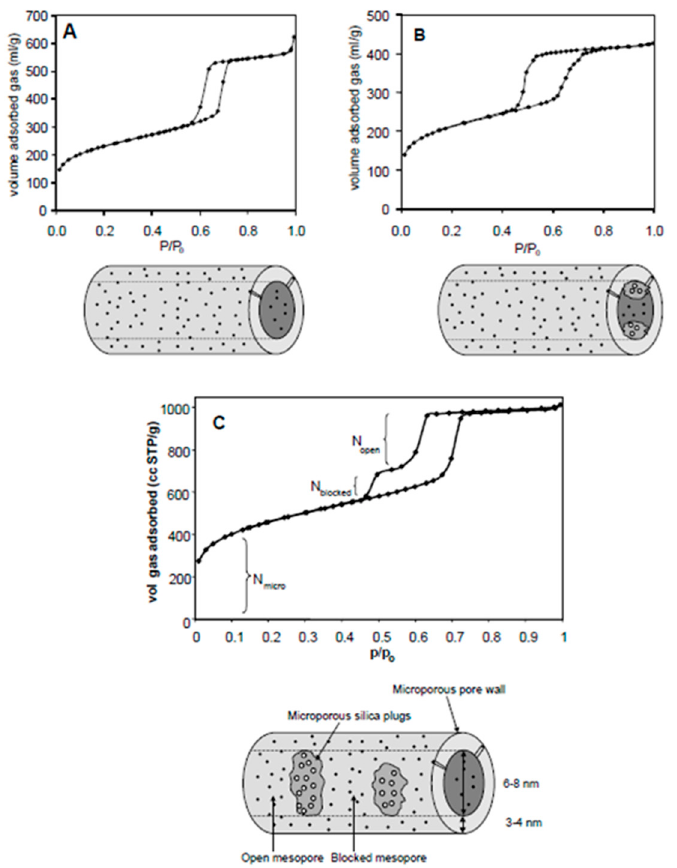
Figure 1. N 2 adsorption–desorption isotherms (upper) and schematic (lower) of ( A ) conventional SBA-15, ( B ) completely plugged SBA-15, and ( C ) partially plugged SBA-15 materials [11,13].